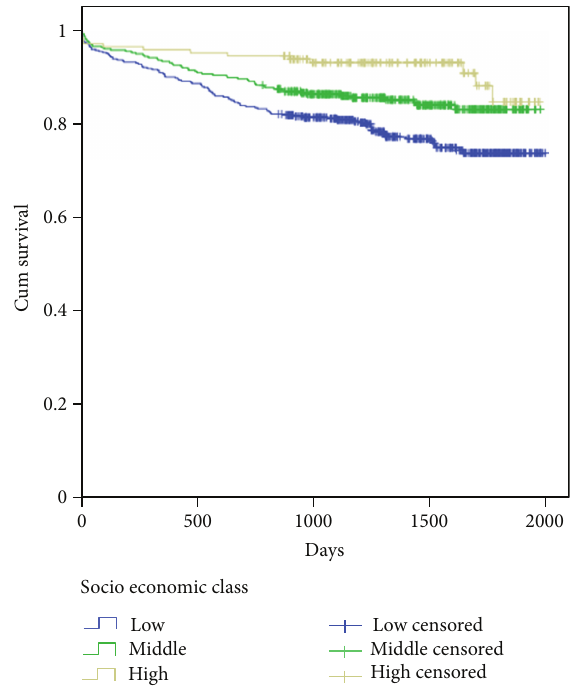
Figure1:Kaplan-Meierplotsdepictingtotalmortalityduring5-year follow-up in individual socioeconomic groups, based on the total patient material.